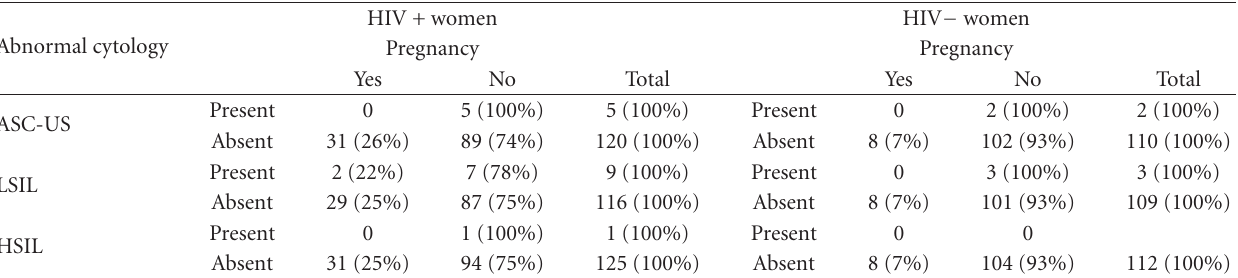
Table 4: Frequency of abnormal cytology in HIV+ and HIV − women correlated with pregnancy. Abnormal cytology